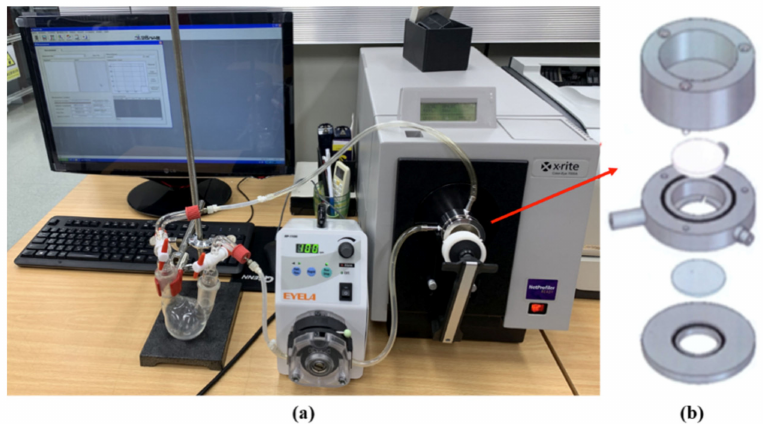
Figure 1. Color measurement system connected to a gas flow device for dynamic color change measurements: ( a ) Optical image of the entire system; ( b ) Schematic diagram of the chamber with a loaded